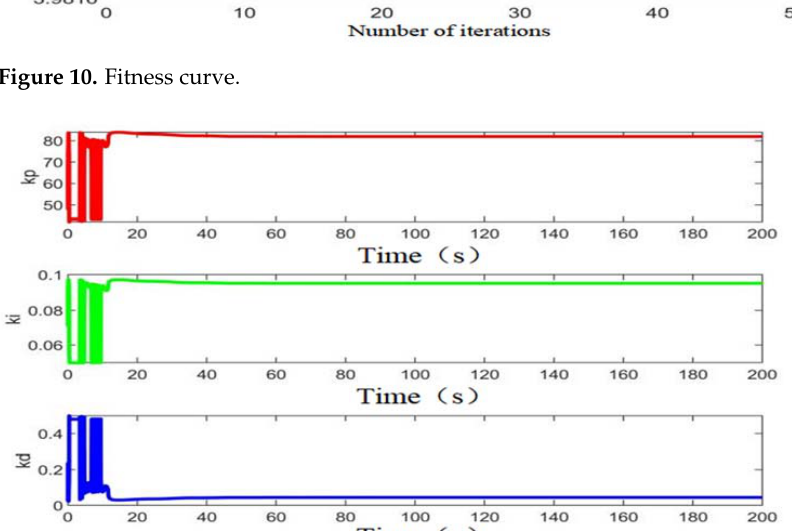
Figure 10. Fitness curve.